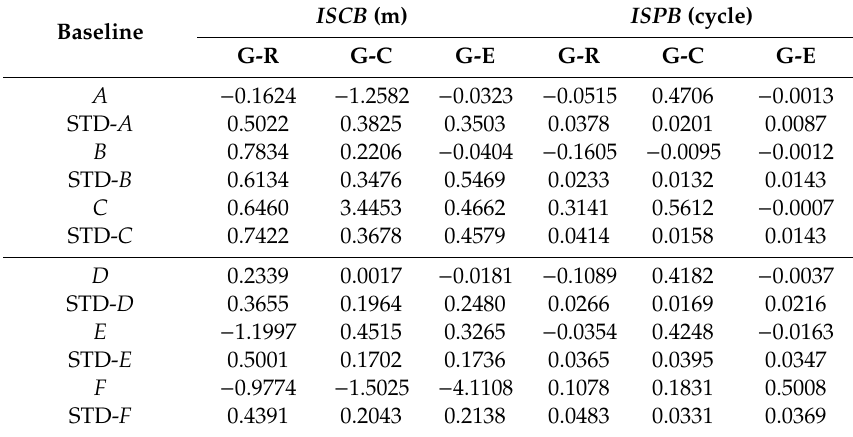
Table 3. Estimated ISCB , ISPB , and the corresponding STDs between GLONASS / BDS / Galileo and GPS. The symbols “G-R”, “G-C”, and “G-E” in the table mean operation between GPS and GLONASS, between GPS and BDS, and between GPS and Galileo, respectively.